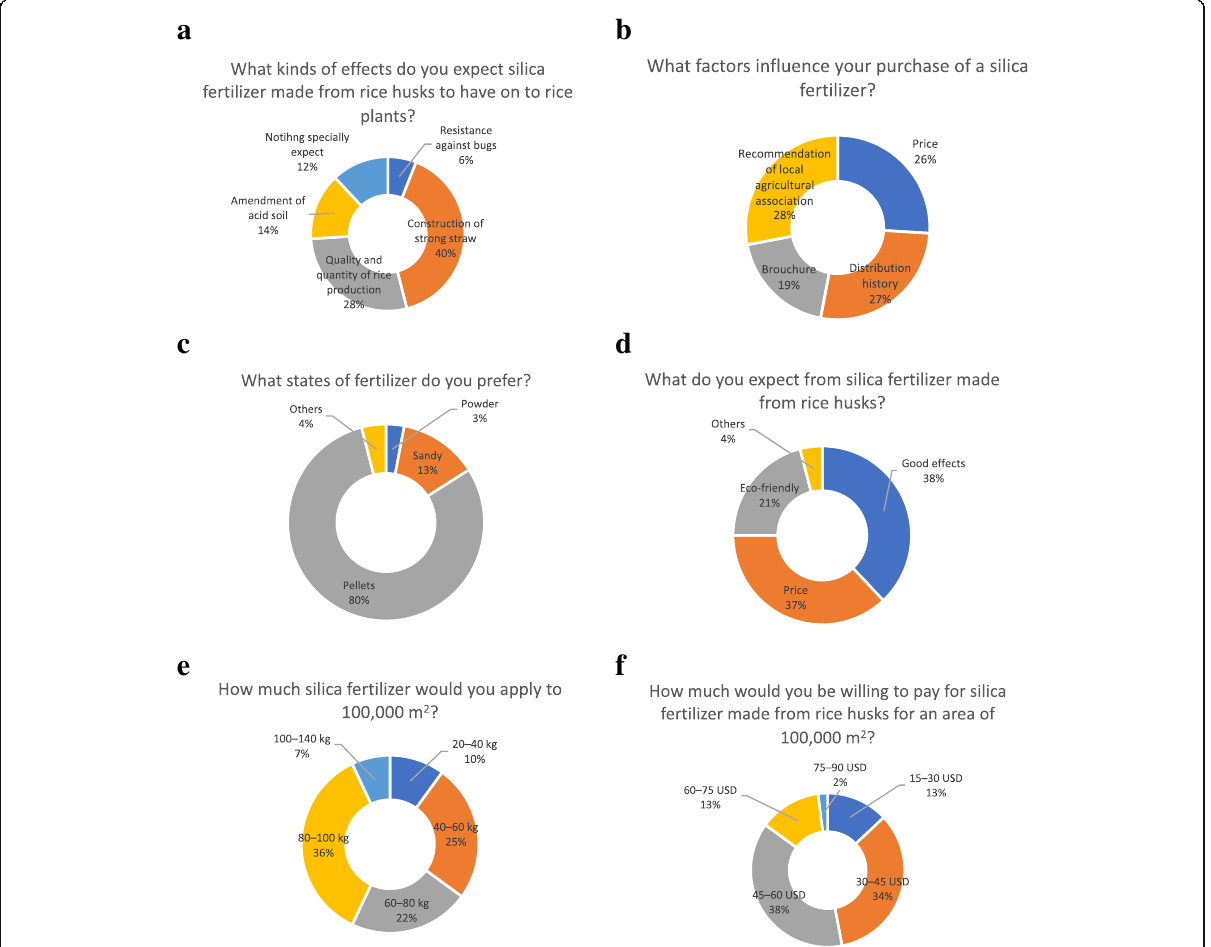
Fig. 5 Results of questionnaire about rice husk silica fertilizers. ( a ) What kinds of effects do you expect silica fertilizer made from rice husks to have on to rice plants? ( b ) What factors influence your purchase of a silica fertilizer? ( c ) What states of fertilizer do you prefer? ( d ) What do you expect from silica fertilizer made from rice husks? ( e ) How much silica fertilizer would you apply to 100,000 m 2 ? and ( f ) How much would you be willing to pay for silica fertilizer made from rice husks for an area of 100,000 m 2